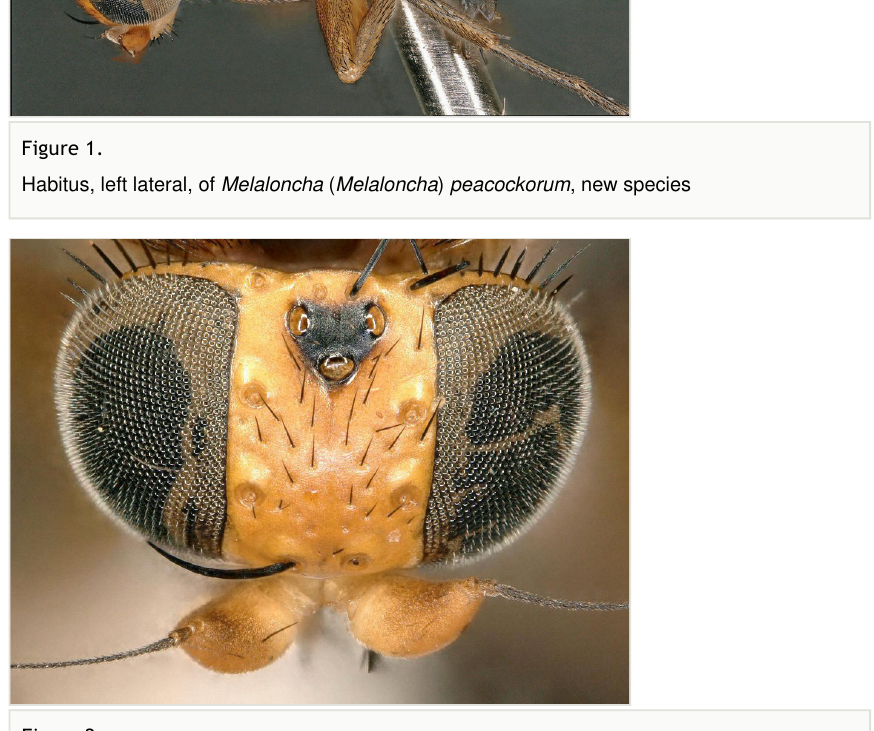
Figure 2. Head, anterior, of Melaloncha ( Melaloncha ) peacockorum new